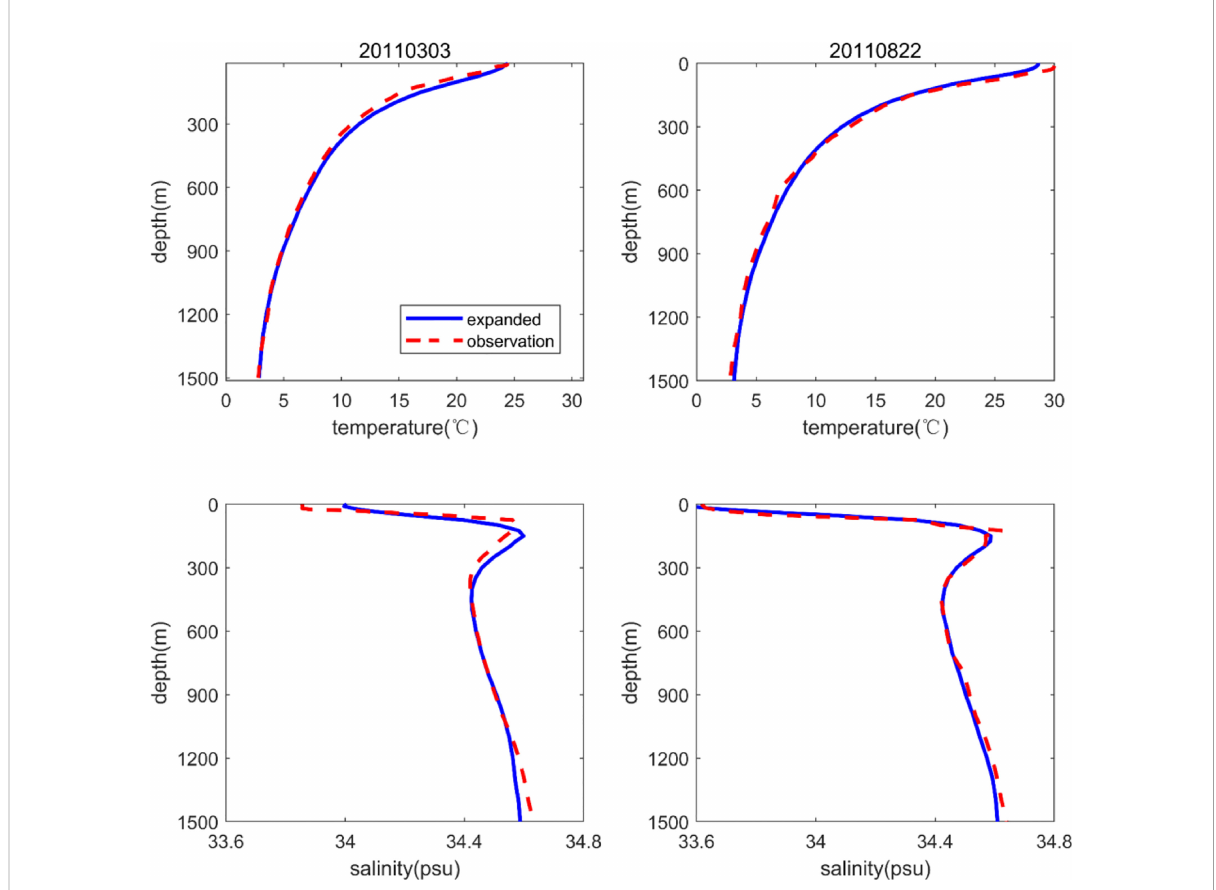
FIGURE 9 T – S pro fi les for two observation stations in the northern South China Sea. The blue and red lines represent the expanded T – S fi eld results and observations (WOD18),